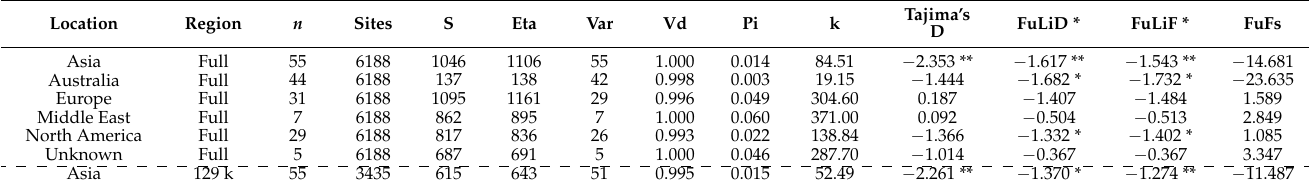
Figure 6. Median-joining networks constructed with PopART 1.7 for movement ( A ) and coat ( B ) proteins using global and Australian and seed interception cucumber green mottle mosaic virus isolates. Node size is proportional to the number of variants. Sequence node colours correspond to the collection regions of isolates. Hatch marks represent the number of single nucleotide variants between nodes. Table 4. Summary of genetic variation, polymorphism, and neutrality test statistic values for cucum- ber green mottle mosaic virus (CGMMV) full coding region, 129 kDa, 186 kDa, MP and CP sequences for 171 CGMMV isolates by collection